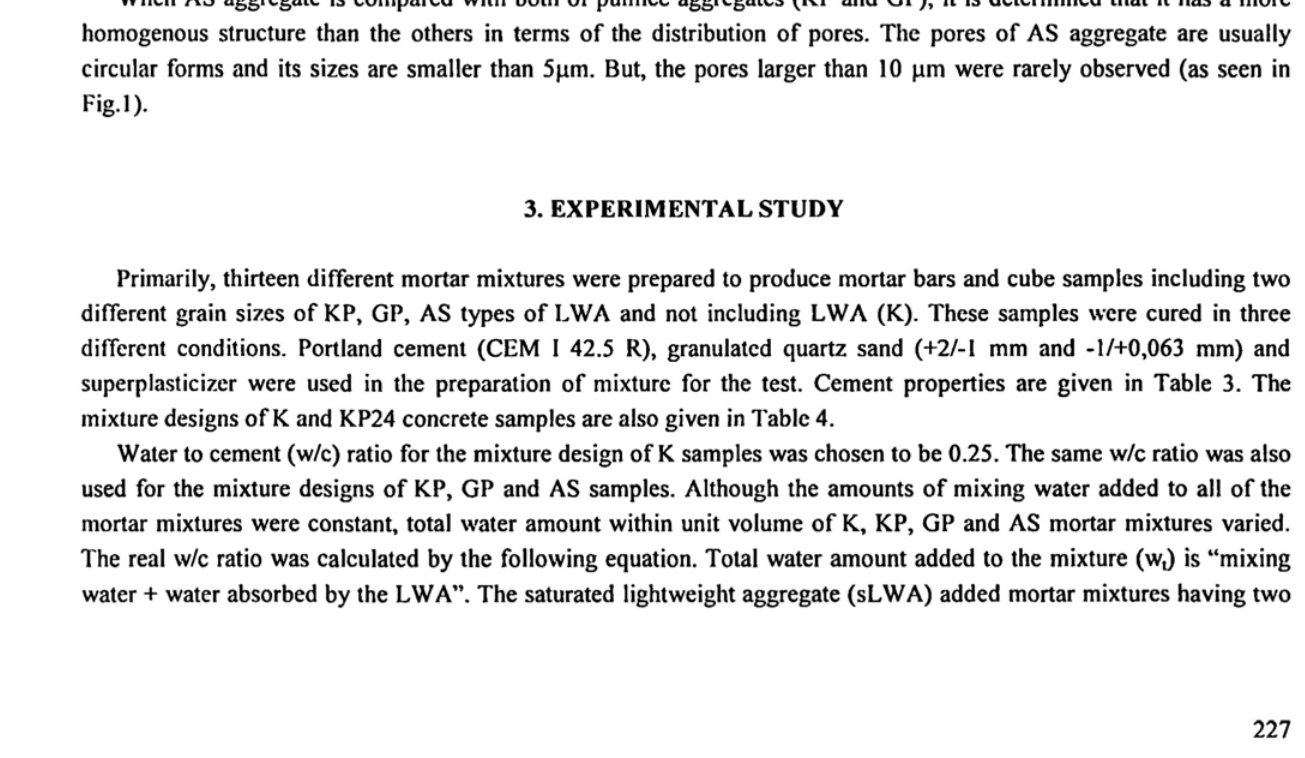
Fig. 1: Pore structures of KP (a), GP (b) and AS (c) aggregates (microscopic